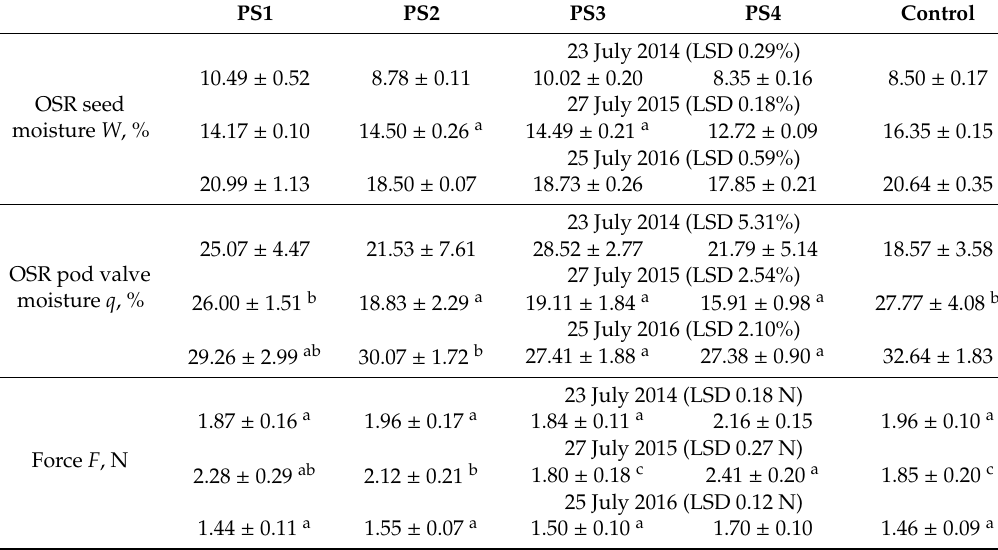
Table 2. Effect of pod sealant on moisture content (mean ± 95% confidence level) of pod valves ( q ) and seeds ( w ) and the force ( F ) necessary for pod opening at harvest in 2014, 2015, and 2016. Values with similar letters were not significantly different at p < 0.05 significance level.